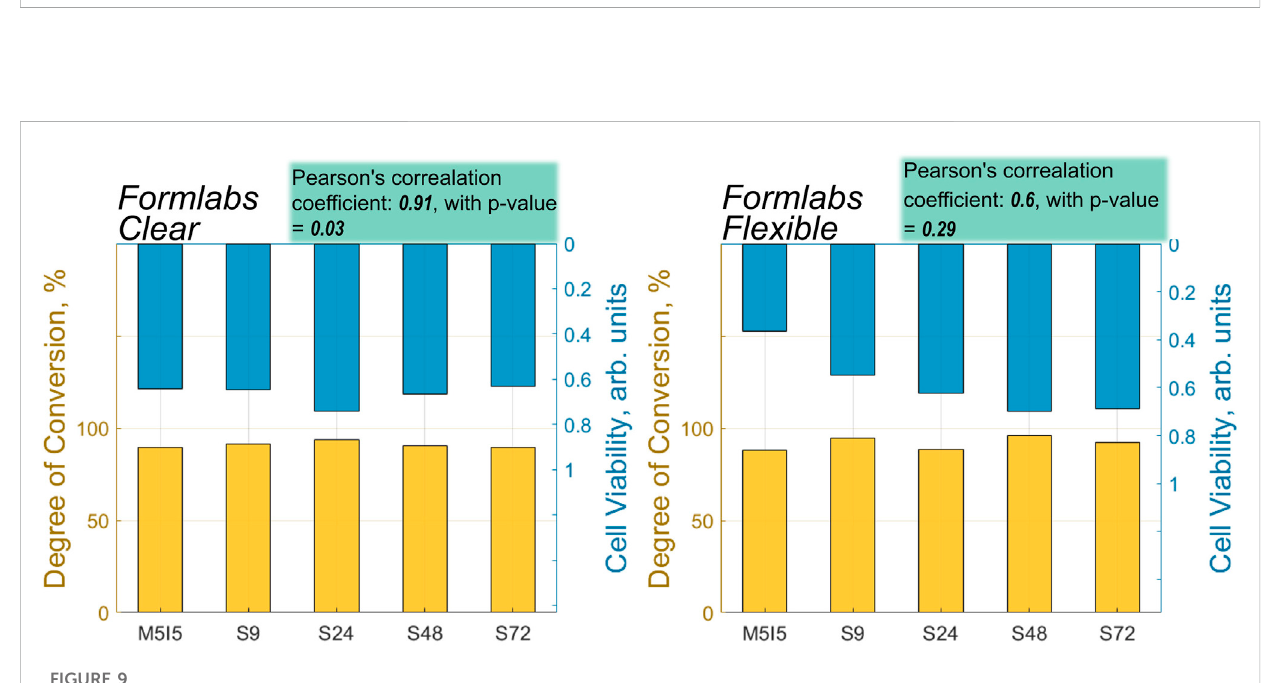
FIGURE 9 A correlation between the values of DC and cell viability of different post-processed samples made from Flexible and Clear resins.